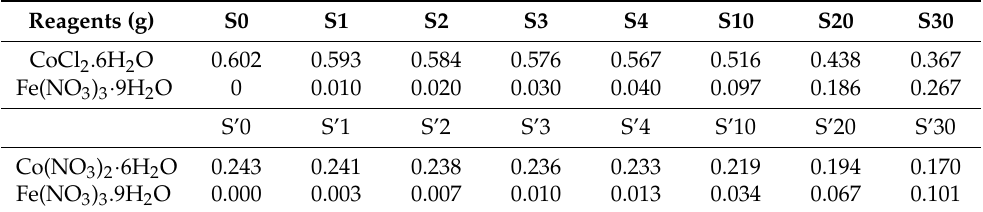
Table 1. Amounts of the metallic reagents used during the